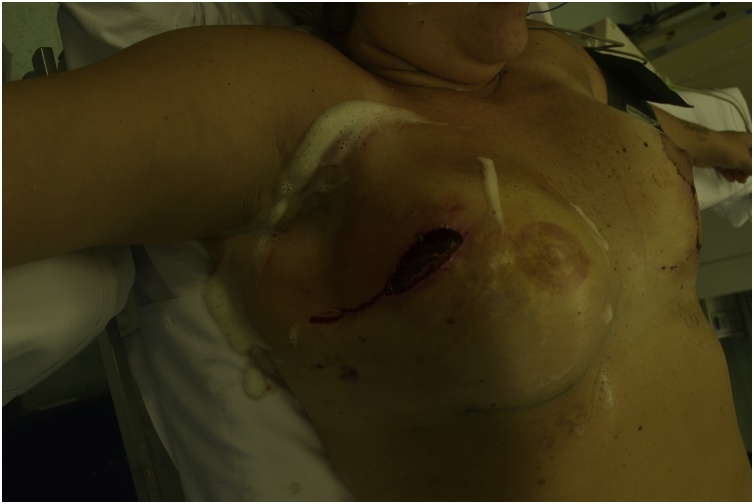
Implant exposure.